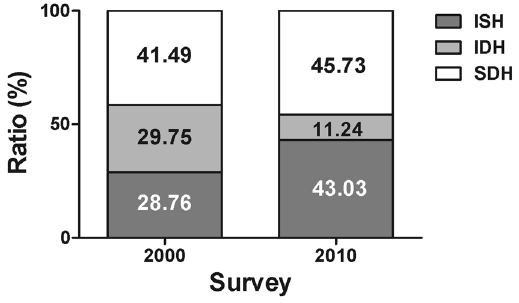
Figure 3. Changes in constituent ratio of hypertension subtypes (ISH = isolated systolic hypertension, IDH = isolated diastolic hypertension, SDH = systolic-diastolic hypertension) over decade.